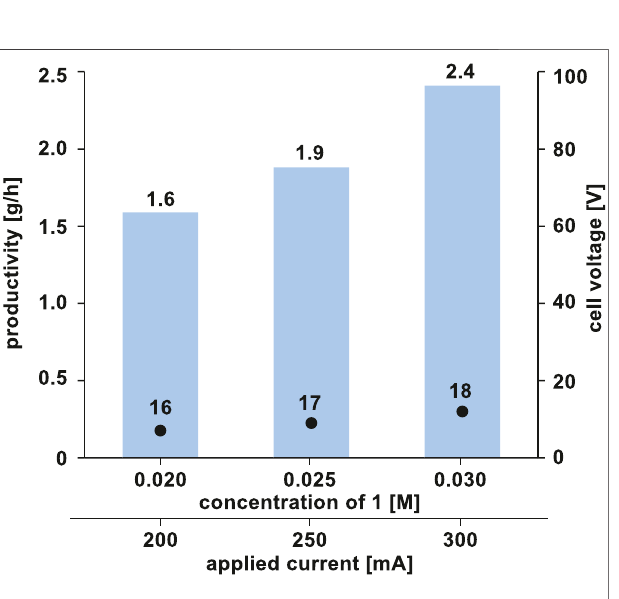
FIGURE 3 | Improving productivity by increasing substrate concentration. Bars and plots represent the productivity and cell voltage,